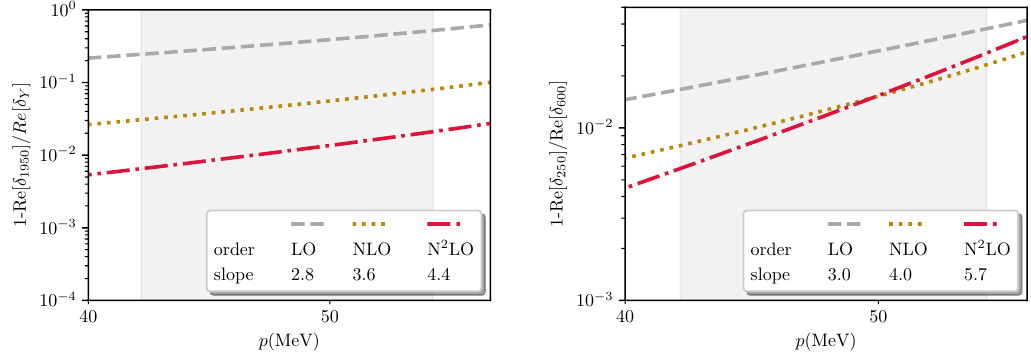
Figure 8 . The Lepage plot (left) and the consistency assessment (right). The number of subtractions at NLO and N 2 LO is equal to one. The curves are fitted by straight lines within the opportunity window (shown by the shaded area). The slopes are seen to increase order by order. Note that the subscript of the phase shift indicates the value of the cutoff Λ , used in the calculations. For example, δ 250 denotes the phase shift calculated using Λ = 250 MeV.